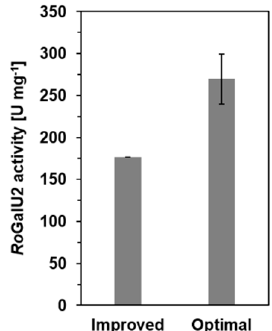
Figure 11. Ro GalU2 activity of the improved activity assay compared to an assay with optimal reaction conditions. Reaction solution for improved test contained 1.5 mM UTP, 250 mM glucose 1-phosphate, 1 mM MgCl 2 , 50 mM Hepes, pH 7.4, 1.7 µg Ro GalU2. Reaction was carried out at 42 °C in 1 mL scale. Reaction solution for optimal test contained 1.5 mM UTP, 250 mM glucose 1-P, 1 mM